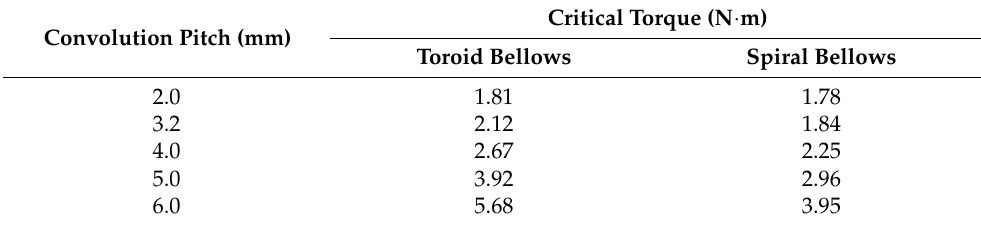
Table 3. Critical torque values of bellows with different convolution pitches.